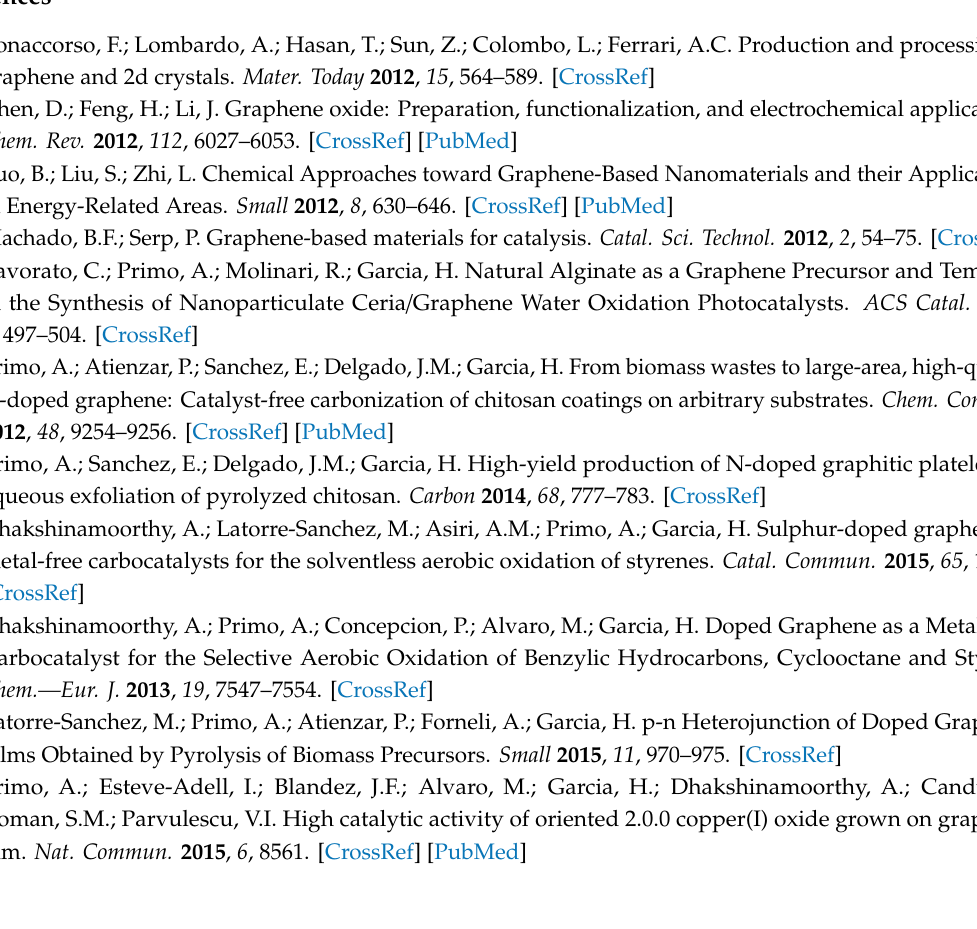
Figure S1: Raman spectra of (N)G prepared from chitosan pyrolyzed at 900, 1000, 1100, 1200 ◦ C under Ar (a) or Ar / H 2 (5%) (b) flow respectively. Figure S2: Raman spectra of G prepared from alginate pyrolyzed at 900, 1000, 1100, 1200 ◦ C under Ar (a) or Ar / H 2 (5%) (b) flow respectively. Figure S3: Raman spectra of (N)G